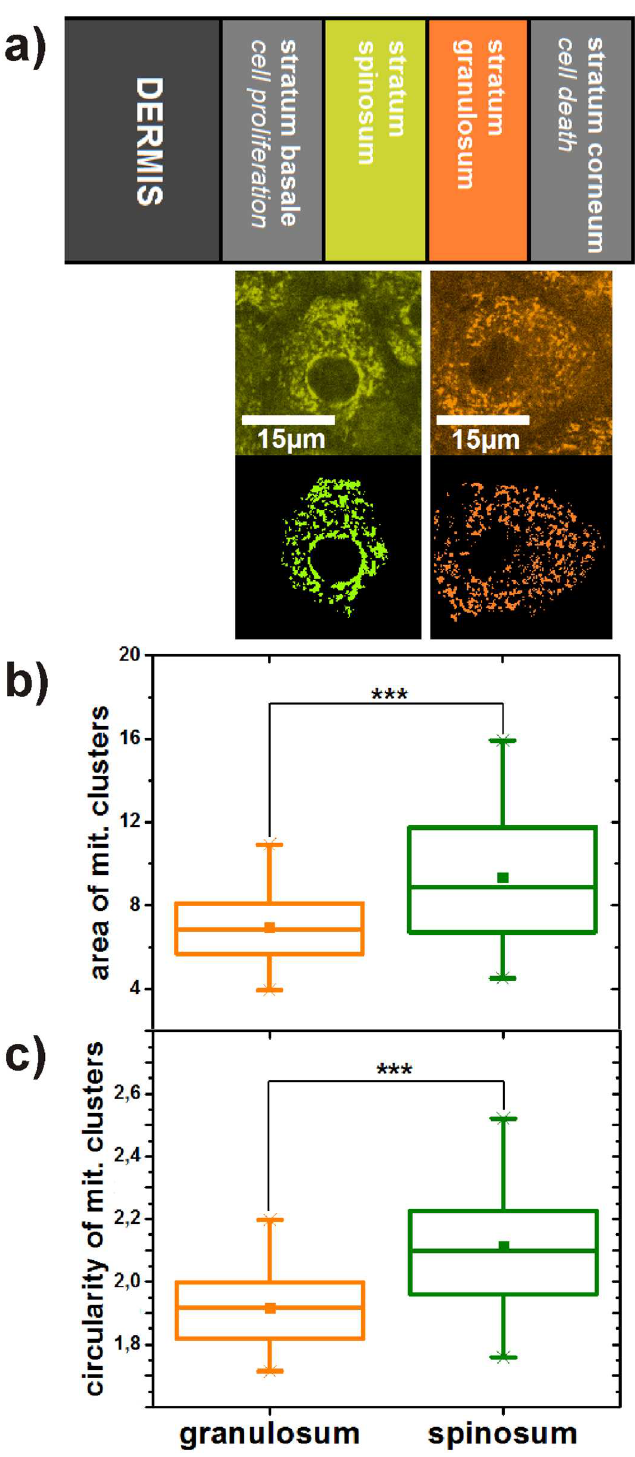
Fig 3. (a) Comparison of mitochondrialnetworksin stratum spinosumand stratum granulosum representing differentstates duringthe differentiation process of keratinocytes. Differentiation-relatedcomparison of size (b) and circularity(c) of mitochondrialclusters in keratinocytes. The p-valuerepresents the probabilityif the two comparedprobability distributions derivefrom the same population. The squarein the box represents the meanvalue,the horizontalline in the center the median.25%percent of the measuredvaluesare lower than the bottom of the box, 75% of them are lowerthan the top of the box. The antennas(whiskers) are the corresponding limits for 2.5% and97.5%. Crossesrepresentthe highestand the lowest valuein the distribution.